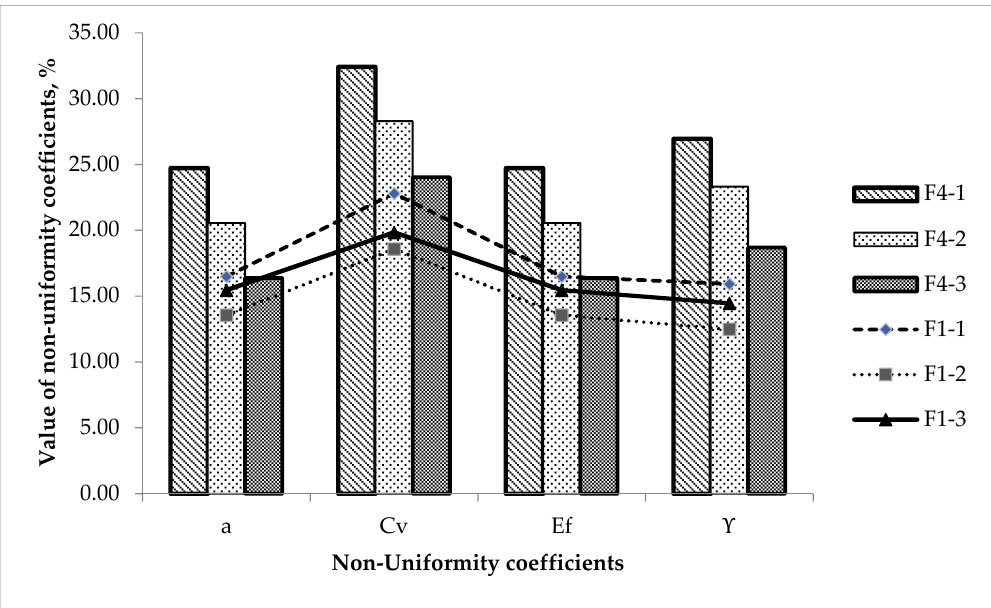
Figure 9. The results of different coefficients of non-uniformity for all experimental fields, all for F1 and F4 where: a— coefficient of non-uniformity according to Oehler, Cv—coefficient of variation, Ef—degree of non-uniformity according to Hofmeister, γ —coefficient of non-uniformity according to Voigt.